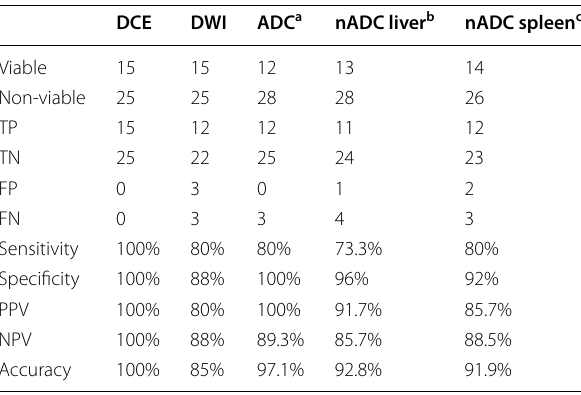
Table 4 Diagnostic performance of DCE, DWI, ADC, normalized ADC liver and normalized ADC spleen